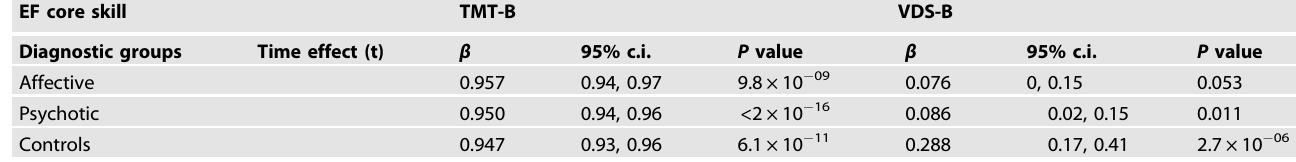
Table 3. Results of the LMM of the discovery sample to test the time effect on lgTMT-B and VDS-B within each diagnostic